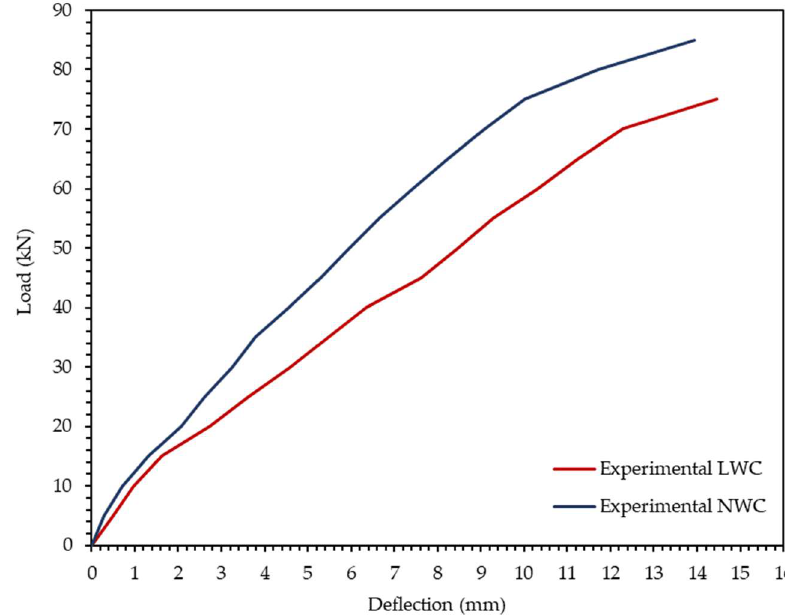
Figure 10. Deflection of LWC and NWC